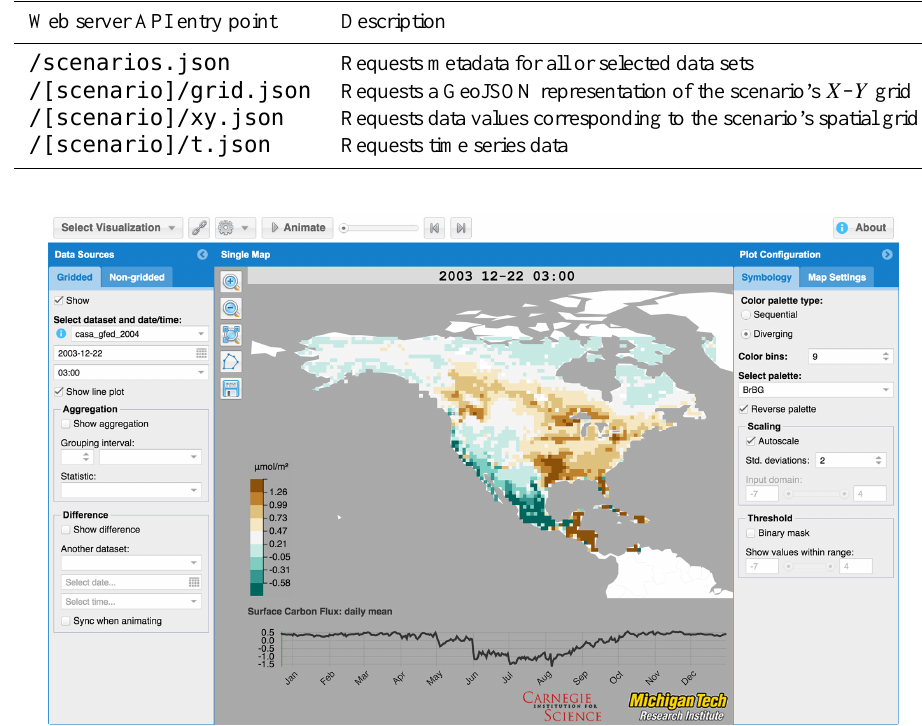
Figure 3. Screenshot of the Carbon Data Explorer web browser application in the Single Map View